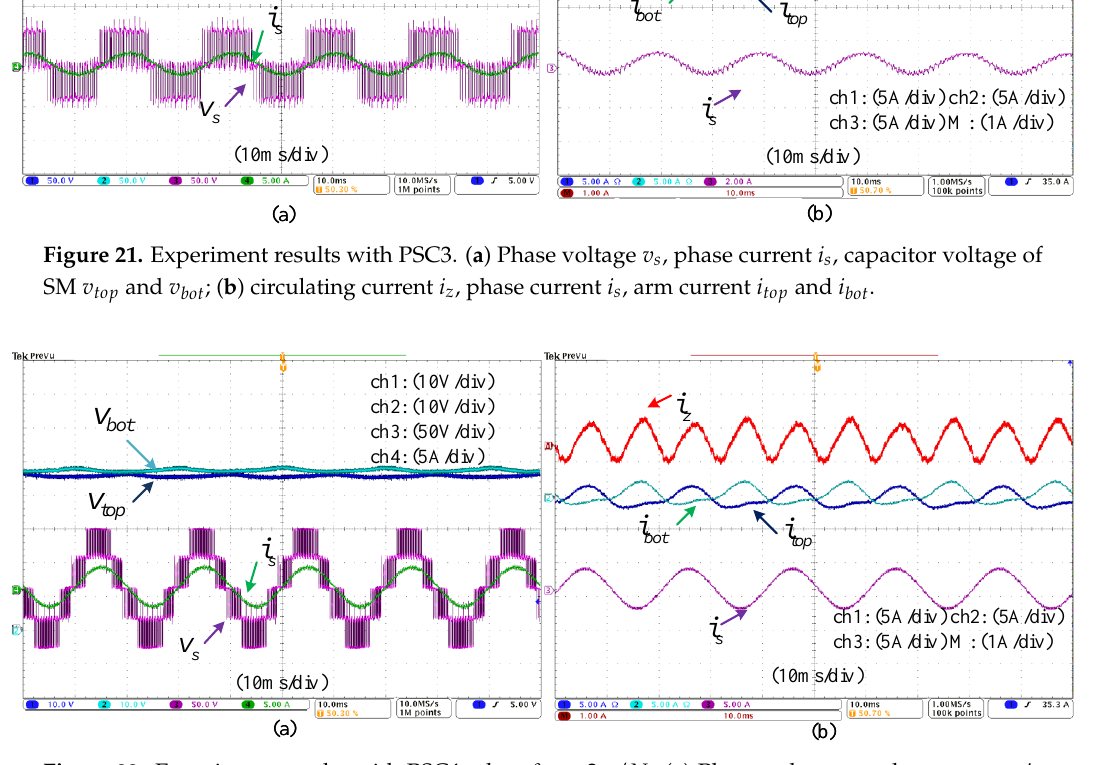
Figure 22. Experiment results with PSC4 when θ 1 = 2 π / N . ( a ) Phase voltage v s , phase current i s , capacitor voltage of SM v top and v bot ; ( b ) circulating current i z , phase current i s , arm current i top and i bot .